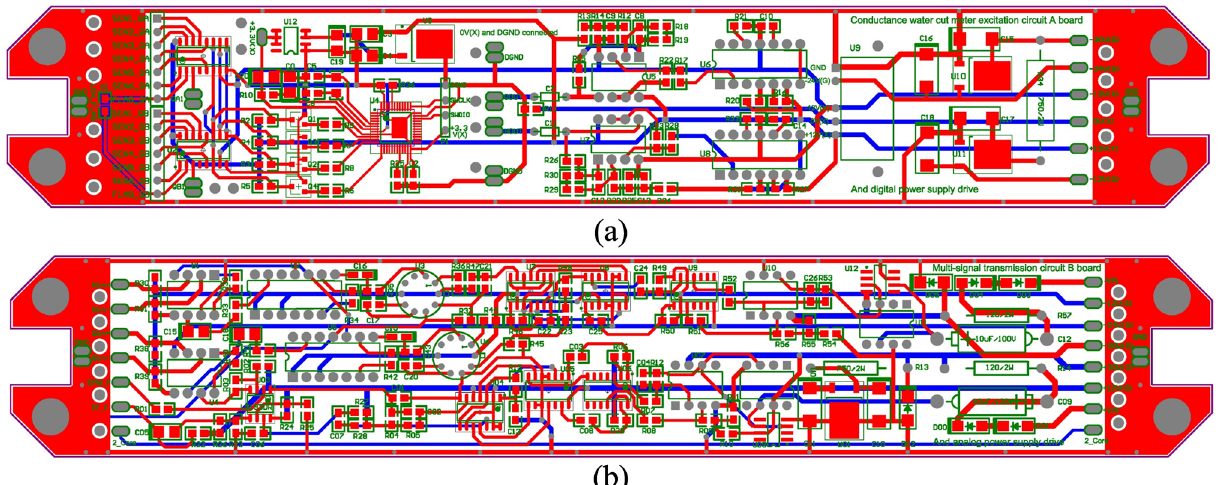
Fig. 10 PCBs of MCPA frequency measurement system circuitry: a conductance water cut meter excitation circuit A board using digital power supply drive, b multi-signal transmission circuit B board using analog power supply